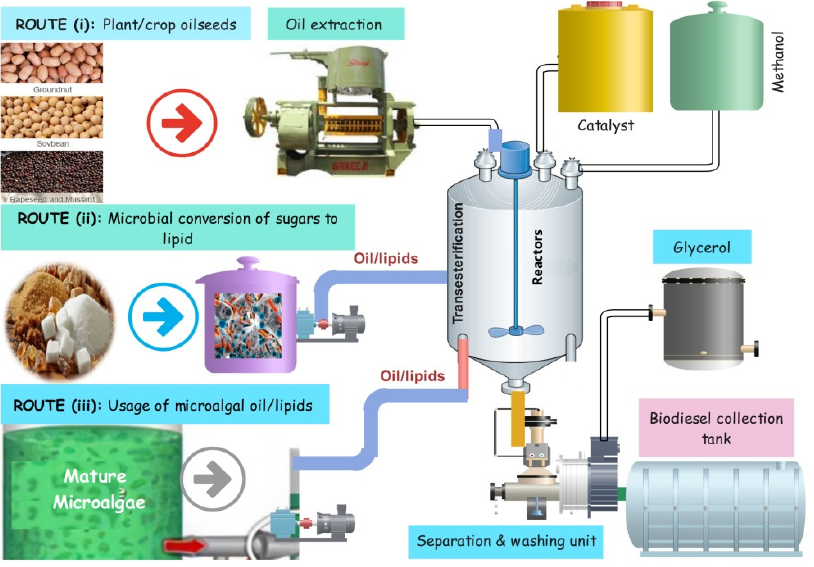
Figure 7. Biodiesel production via the transesterification process through three important routes.